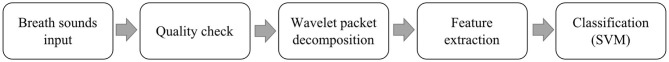
Major components of the automated adventitious breath sound detection performed by the AI algorithm.